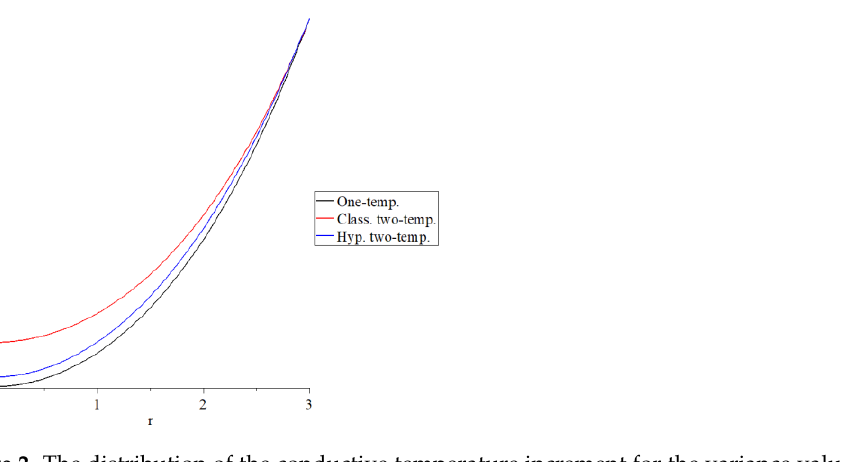
Figure 2. The distribution of the conductive temperature increment for the variance values of the two-temperature parameter when D = 0.2.